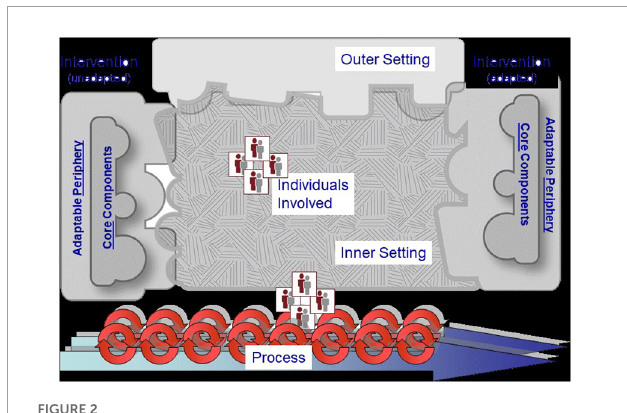
FIGURE2 The Consolidated Framework for Implementation Research (CFIR) of Damschroder et al.